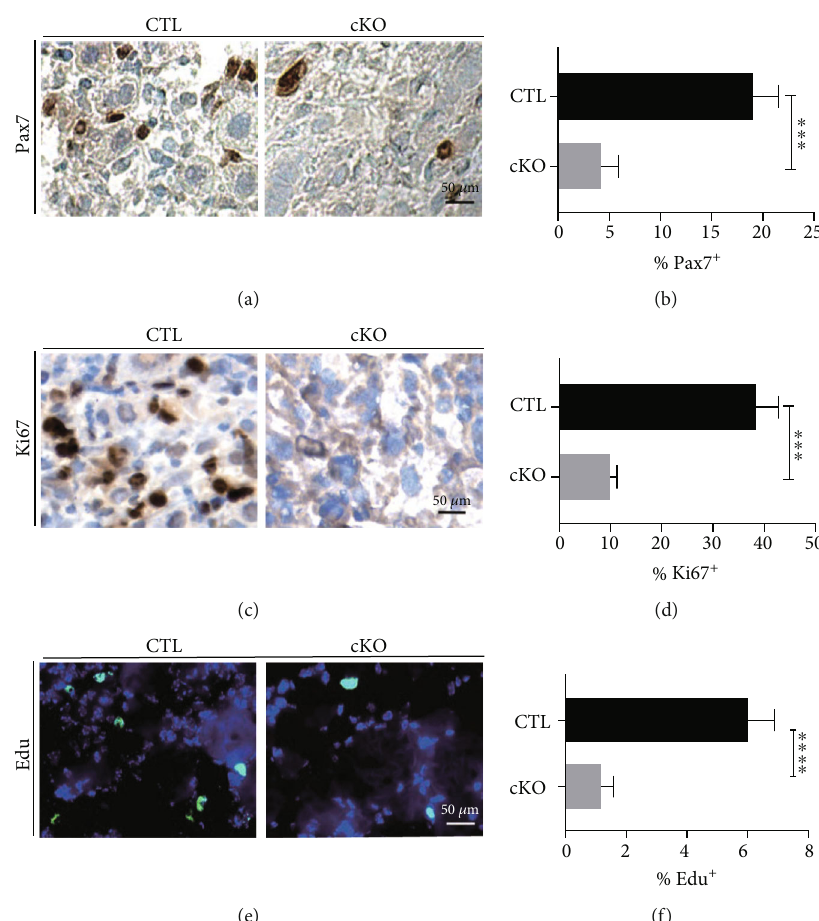
Figure 2: METTL3 regulates muscle stem cell proliferation in vivo . (a – d) Immunohistochemical analysis of TA muscle samples from METTL3 cKO and control by Pax7 and Ki67 antibodies, respectively. Quanti fi cations of Pax7 and Ki67 staining were shown on the right. (e) EdU of TA muscles and (f) images of cell numbers 5 days after isolation from injured muscles of METTL3cKO and control mice. ∗∗∗∗ p < 0 : 0001 ; ∗∗∗ p < 0 : 001 . CTL: control; cKO: METTL3 conditional